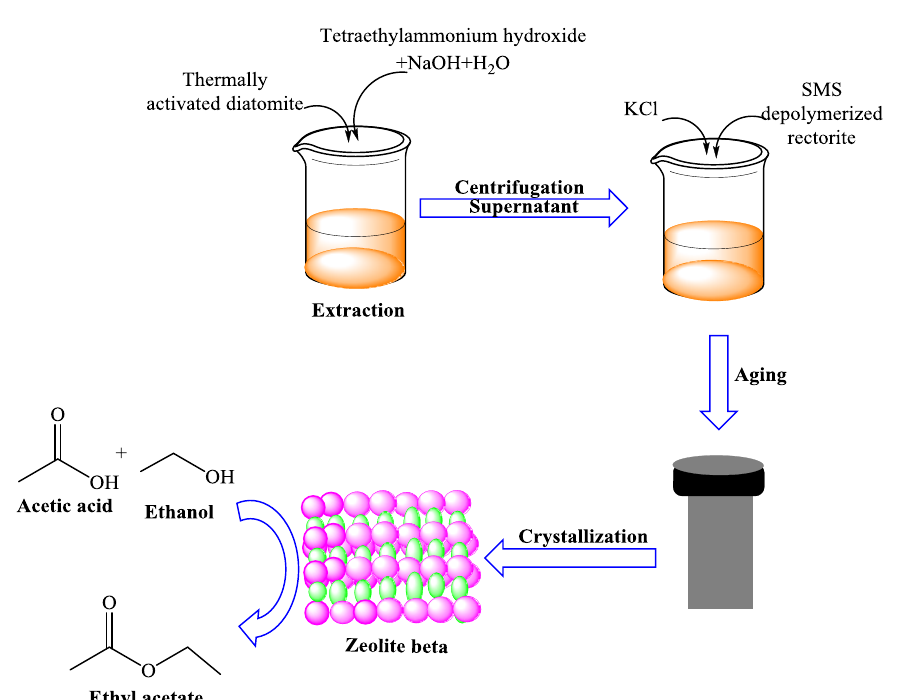
Figure 4. Schematic diagram of preparation of β -zeolite and its application in the synthesis of ethyl acetate via acetic acid esterification with ethanol